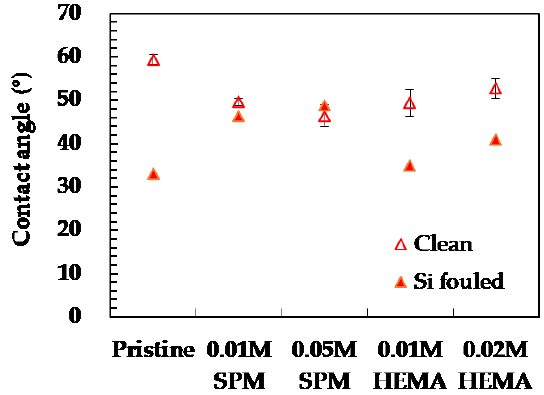
Figure 2. Contact angle of the pristine and modified NF90. Error bars represent one standard deviation of triplicate measurements.